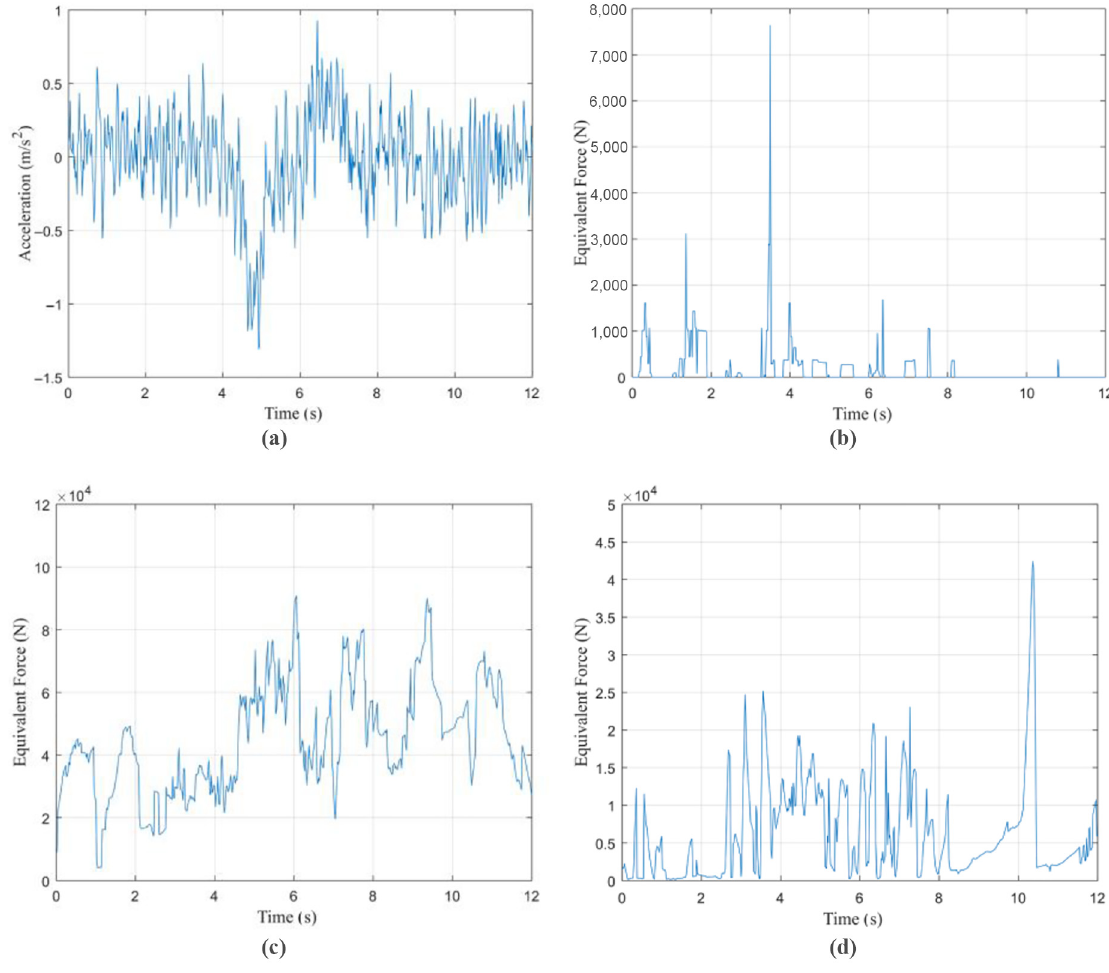
Figure 13 The test